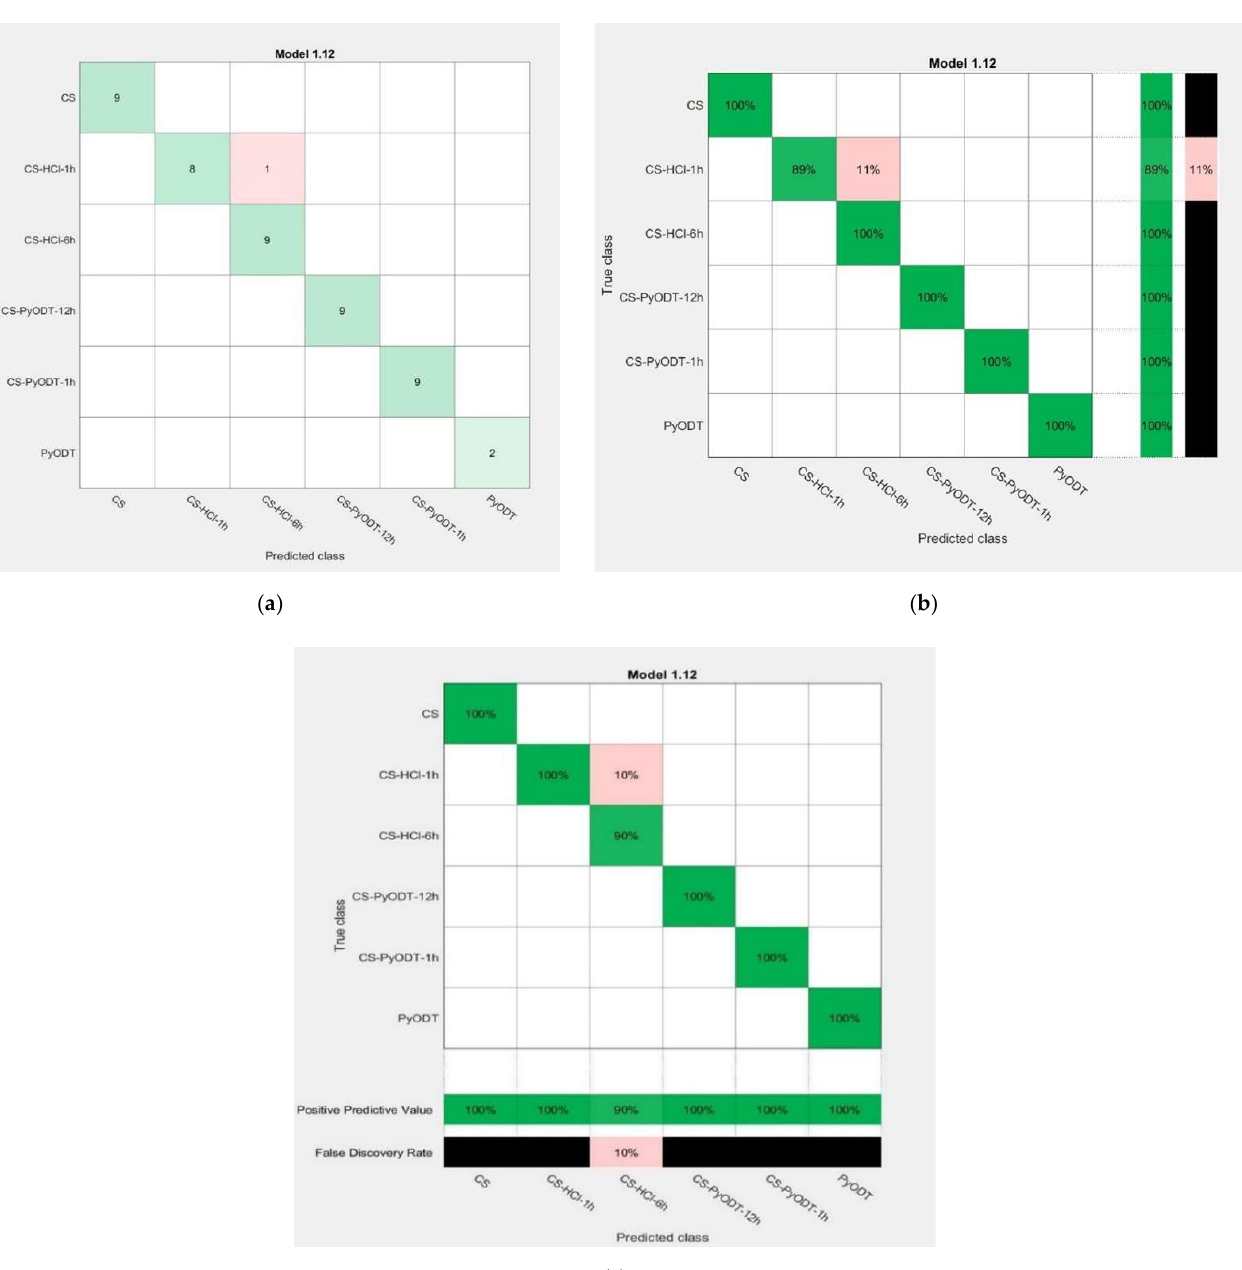
Figure 13. Confusion matrix obtained for the five types of surfaces found onto the C-steel electrode during the study and solid PyODT-corrosion inhibitor; classification indicated as the number of observations ( a ), true positive vs. false-negative rates ( b ), or positive predicted value vs. false discovery rate ( c ).